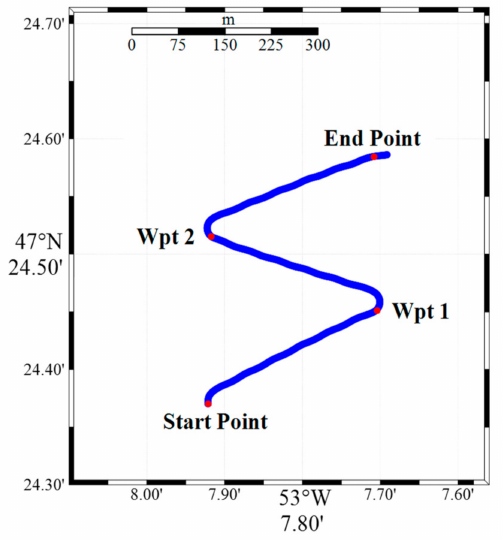
Figure 22. Trajectory of the glider in the mission testing the adaptive waypoint behavior.